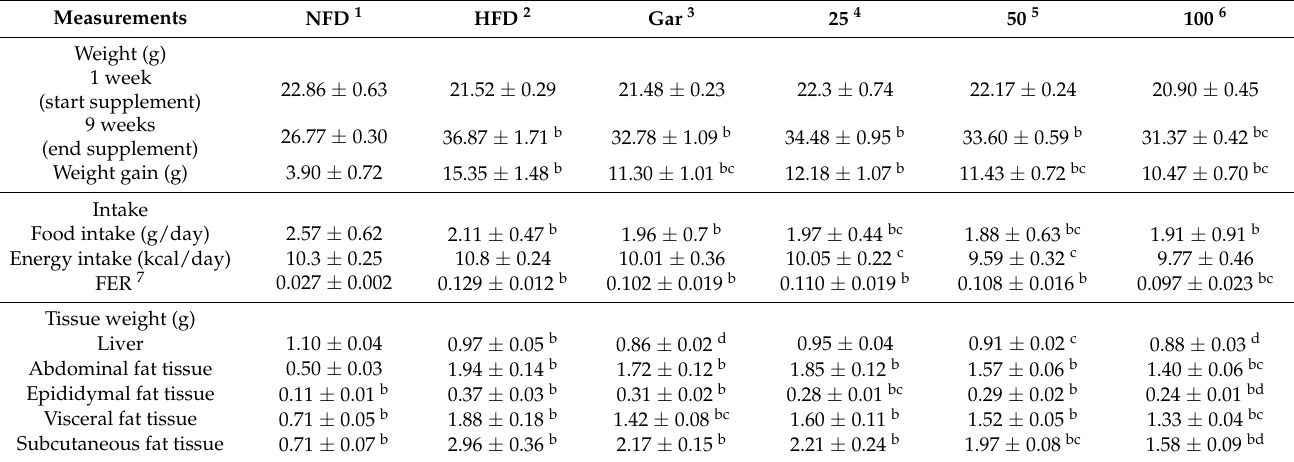
Table 1. Measurement of body and tissue weight, food intake, and